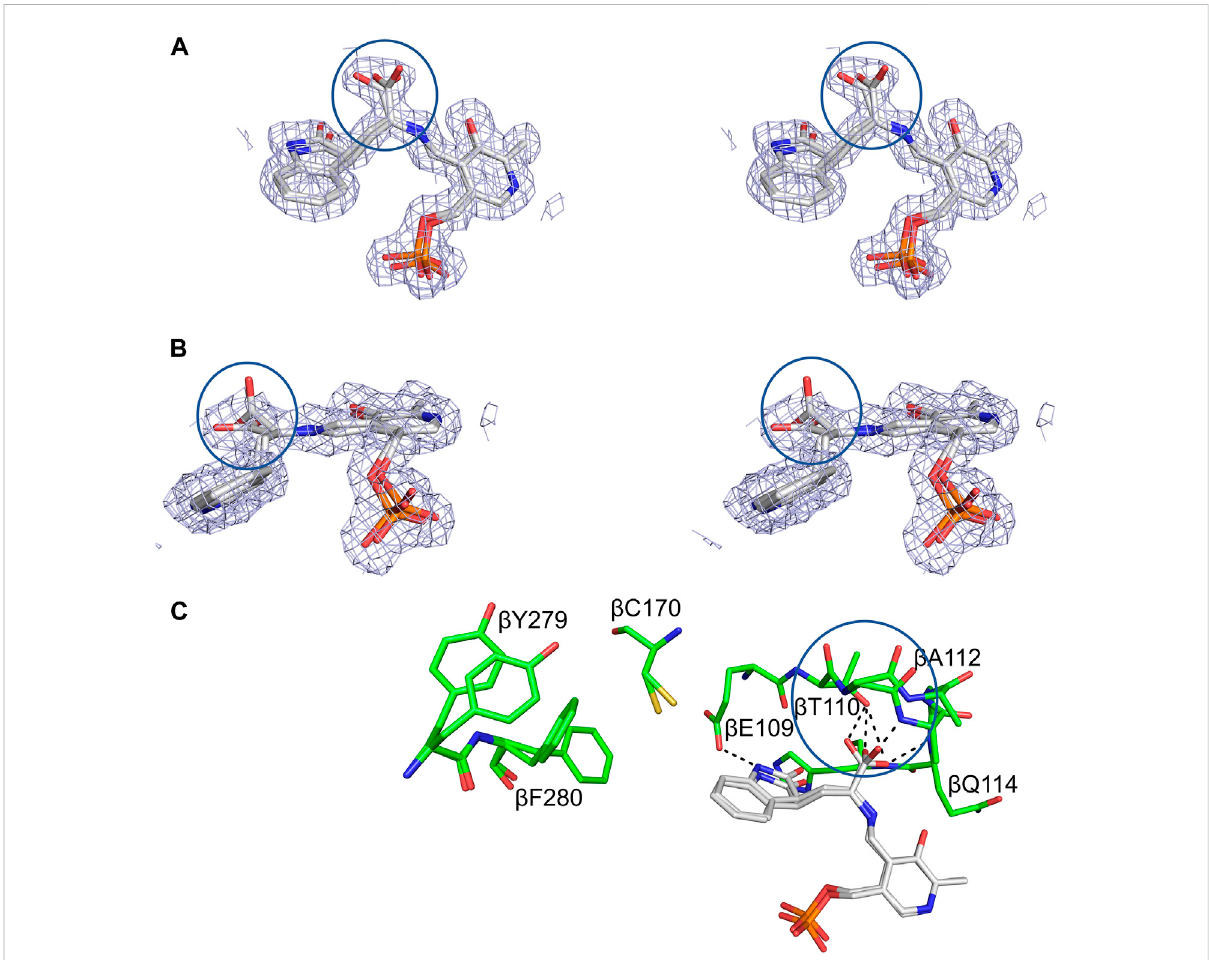
FIGURE 12 Structural detail of theTS β -site complexedwith OIA. (A,B) Crossed-eye stereoviews of the2(Fo-Fc)electron density map at 1 σ of thecomplex viewed from the side and top. (C) Stick representation of the interactions between OIA covalently bound to PLP in the OIA-PLP complex. Hydrogen bonding contacts of the OIA-PLP complex with the carboxylate binding loop are shown as black dashes. The complex contains both an external aldimine, with the α -carboxylate perpendicular to the PLP plane, and a carbanion structure, with the α -carboxylate in the PLP plane (circles). Loop β L3, β 109- β 114, adopts two different conformations to accommodate the carboxylates of the aldimine and carbanion complexes. Coloring schemes: (A,B) carbons white. (C) protein residues, carbons green; OIA, carbons white. All other atoms in standard CPK colors. Figure redrawn from Phillips and Harris